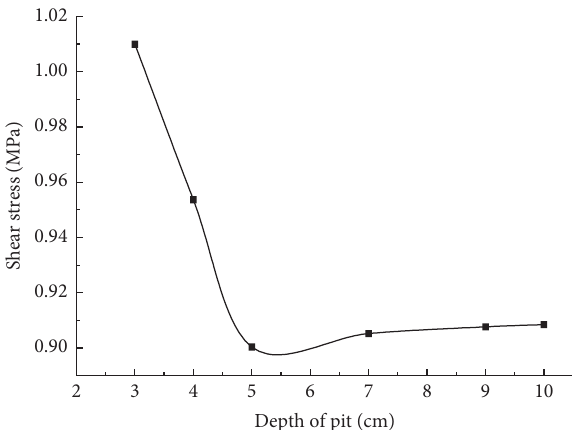
Figure 18: The effect of depth of pit on shear stress of joint filling materials.